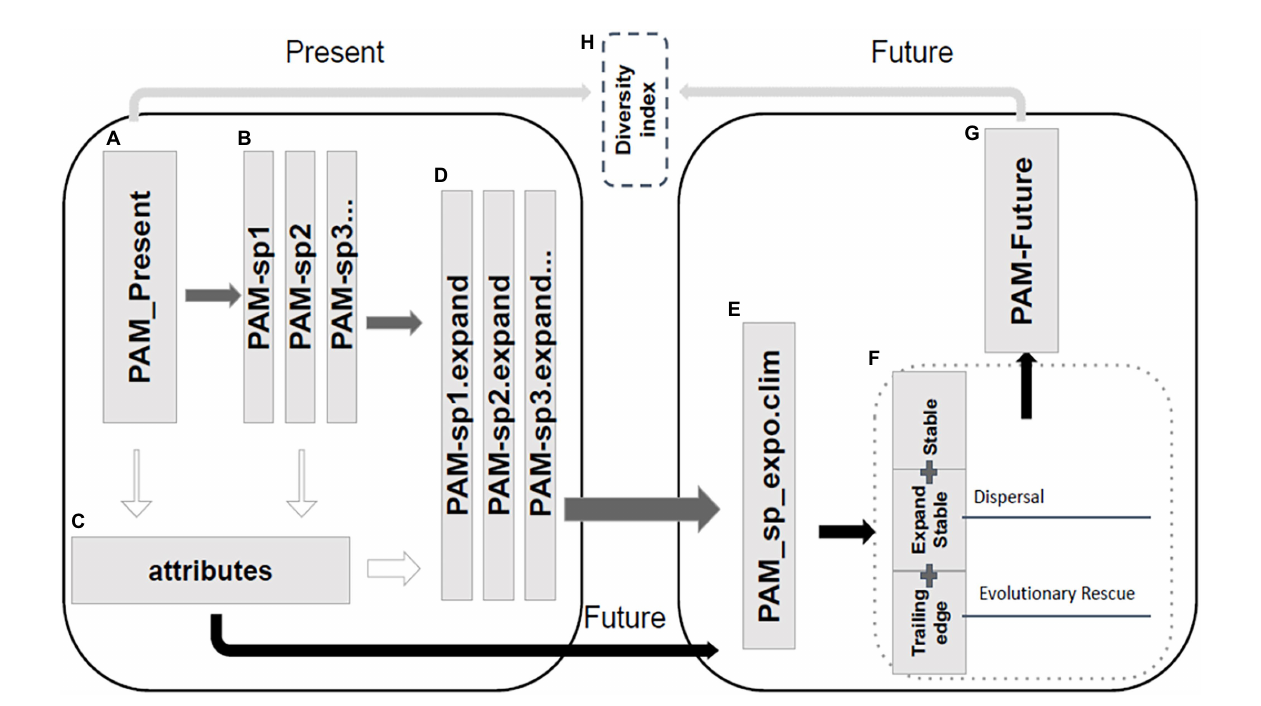
FIGURE 1 (A) Creation of the presence and absence matrix in the present from the range polygons of each amphibian species using the lets.presab function from the letsR package. (B) We performed the analysis at the population level. For that, each species’ range was split into populations of 4 or fewer cells. For example, a species with a range of 20 cells is divided into five populations of four cells (PAM_sp1). Species with <4 cells were supposed to have a single population. (C) Calculation of the attributes of species and their populations (Biome, Altitude, Bio8). (D) Dispersion in the Present to the immediate neighborhood, with probabilistic occupation, considering the limits of the Biome, altitude, and climate. (E) Exposure of populations to future climate, considering the maintenance of populations that remain within the 95% tolerance range of the climatic limits of the species. (F) Definition of climate futures, with the separation of climatic regions (stable region, leading-edge, and trailing edge). Leading Edge is the dispersal region for accessible areas in the future. Trailing-edge is the range area in the present that is not suitable for the species in the future. In this region, the adaptive potential of the species is tested. (G) Unification of populations into a PAM of species in the future. (H) Verification of changes in species diversity (richness and temporal